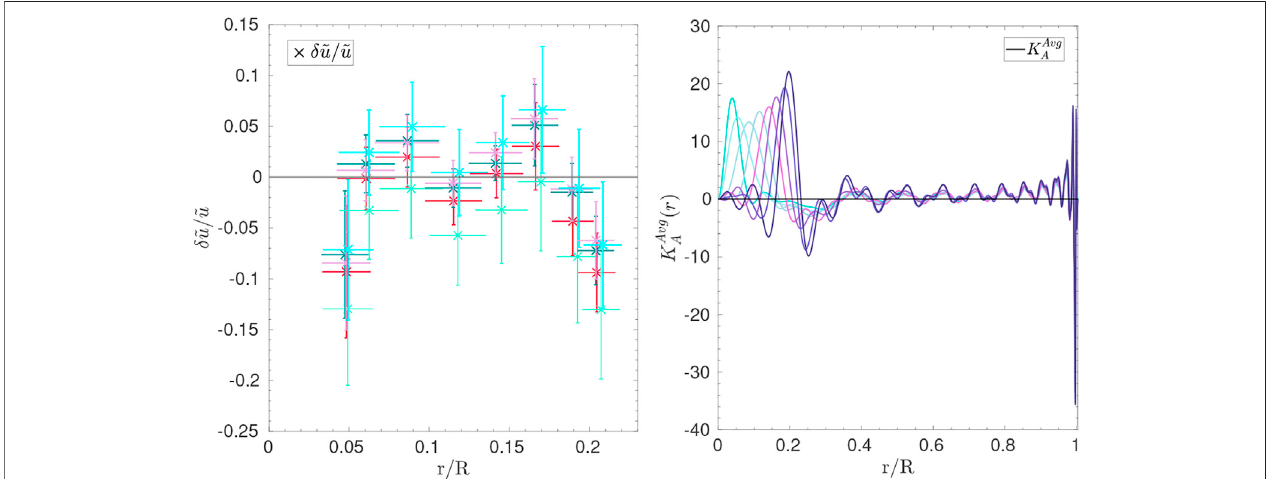
FIGURE 6 | Left : relative differences in dimensionless squared isothermal sound speed for 16CygA as a function of normalized radius. Each colour represents a different reference model for the inversion. The set of reference models is that of Buldgen et al. (2022), Table 2. Right : averaging kernels for the localized inversion of 16CygA using the ( u , Y ) structural pairs [adapted from Buldgen et al.